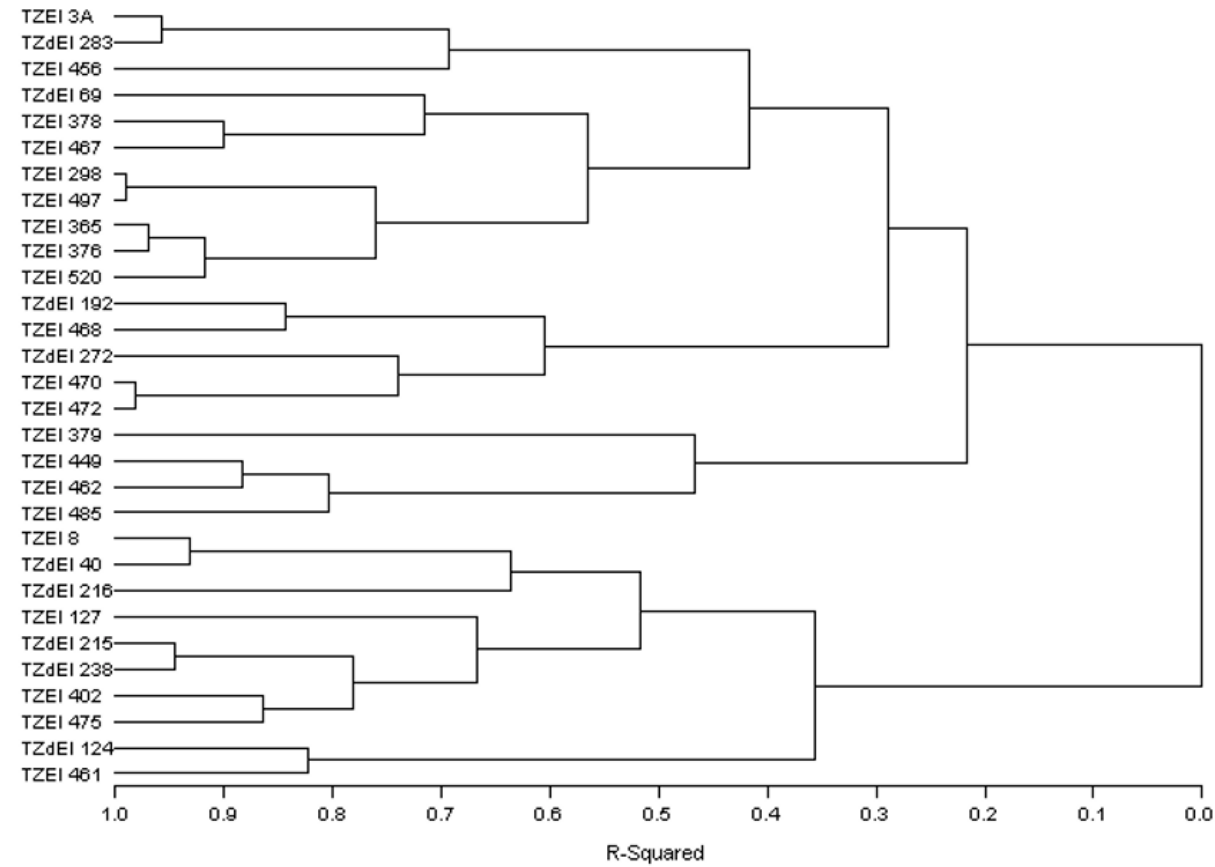
Figure 1. Dendrogram of thirty early maturing maize inbred lines obtained using Ward’s minimum variance cluster analysis based on the HGCAMT effects method across four Striga -infested environments, 2016–2017.